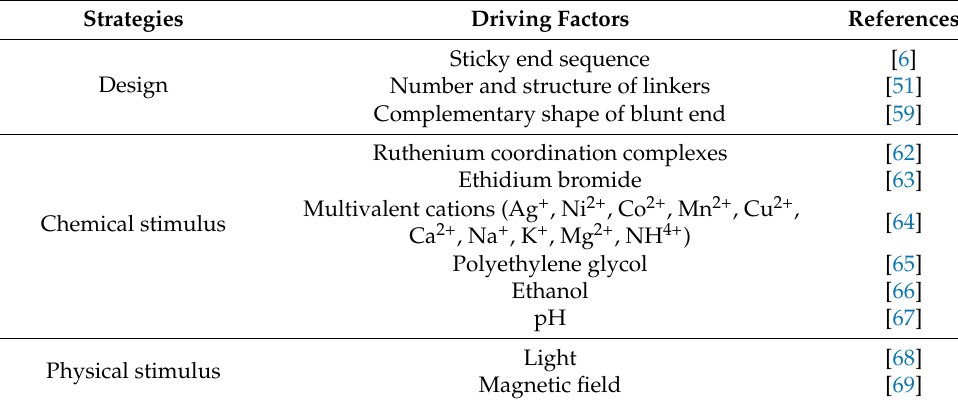
Table 1. Driving factors of dynamic assemblies of 3D